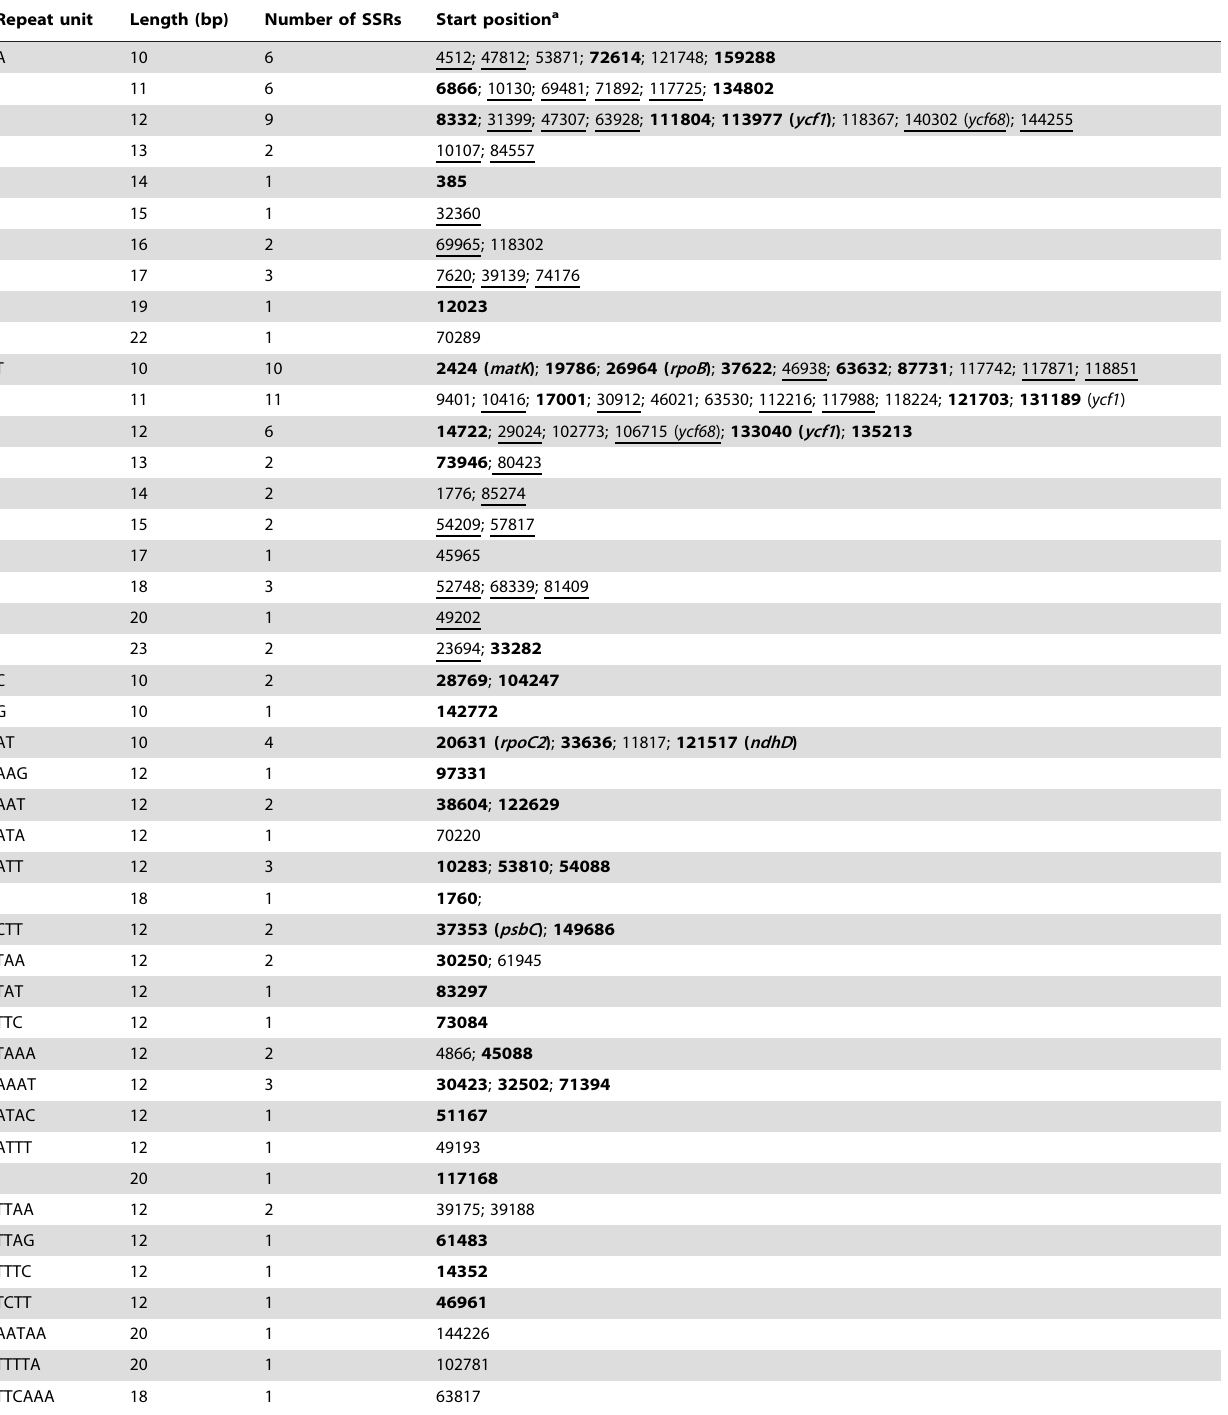
Table 3. List of simple sequence